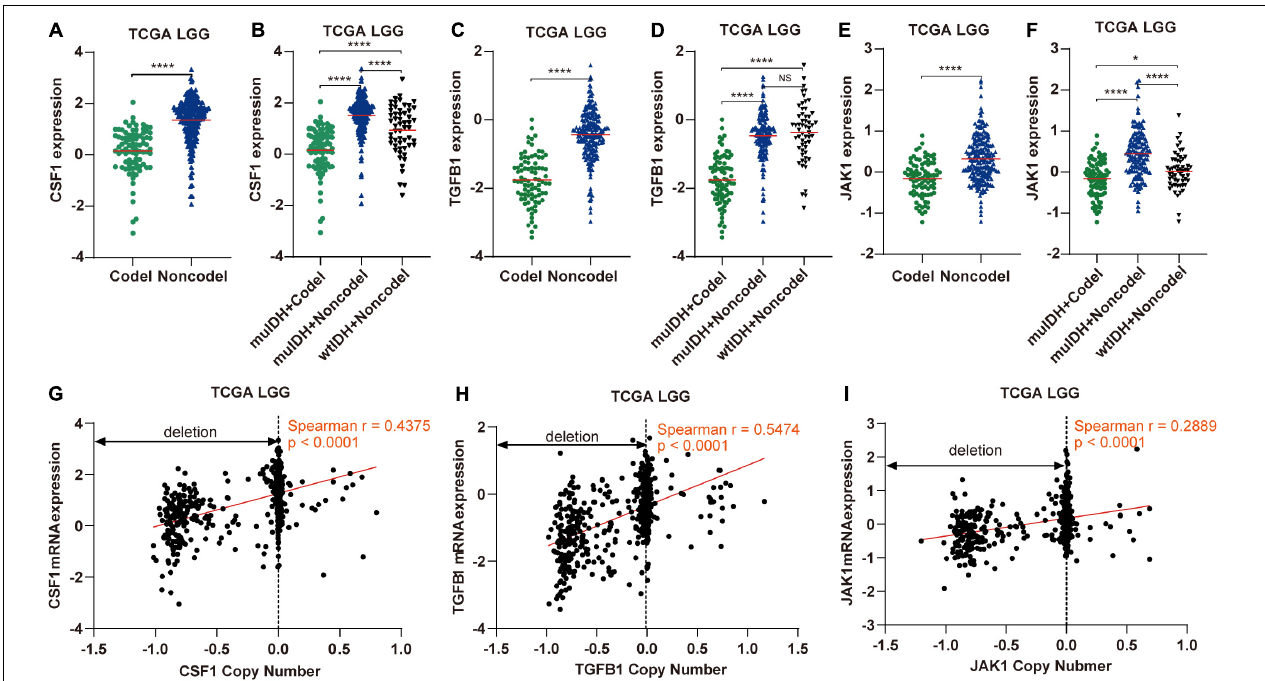
FIGURE 9 | The expression and copy number of CSF1, TGFB1, and JAK1 among different subgroups classified by IDH mutation and 1p/19q codel status in TCGA LGG. (A,C,E) The expression of CSF1, TGFB1, and JAK1 in 1p/19q codel and 1p/19q non-codel LGGs in TCGA LGG dataset. (B,D,F) The expression of CSF1, TGFB1, and JAK1 in different subgroups. The mean mRNA expression was indicated by red lines. P values are inferred from a two-sided Student’s t -test or Mann-Whitney test. (* p < 0.05, **** p < 0.0001). (G–I) Correlation analysis between copy number alteration and mRNA expression of CSF1, TGFB1, and JAK1 in TCGA LGG,